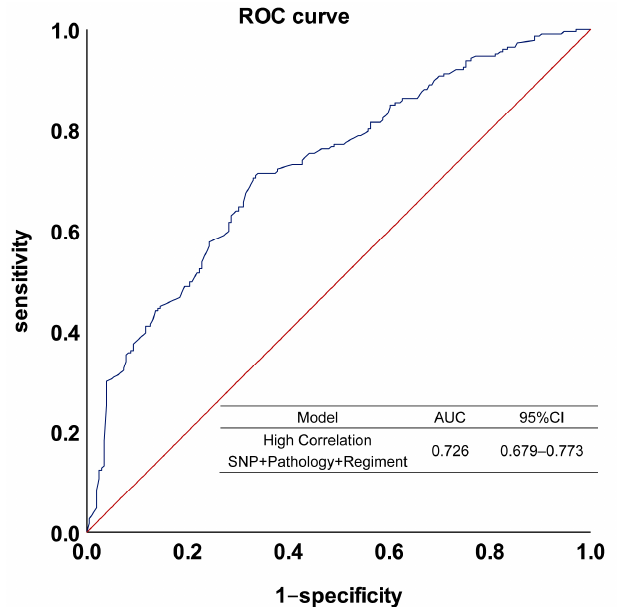
Figure 7. The performance of the platinum–based chemotherapy response model in the combined cohort. The model was established by SNPs combined with pathology and regimen. The blue line is the model fit curve and the red line is the reference line.